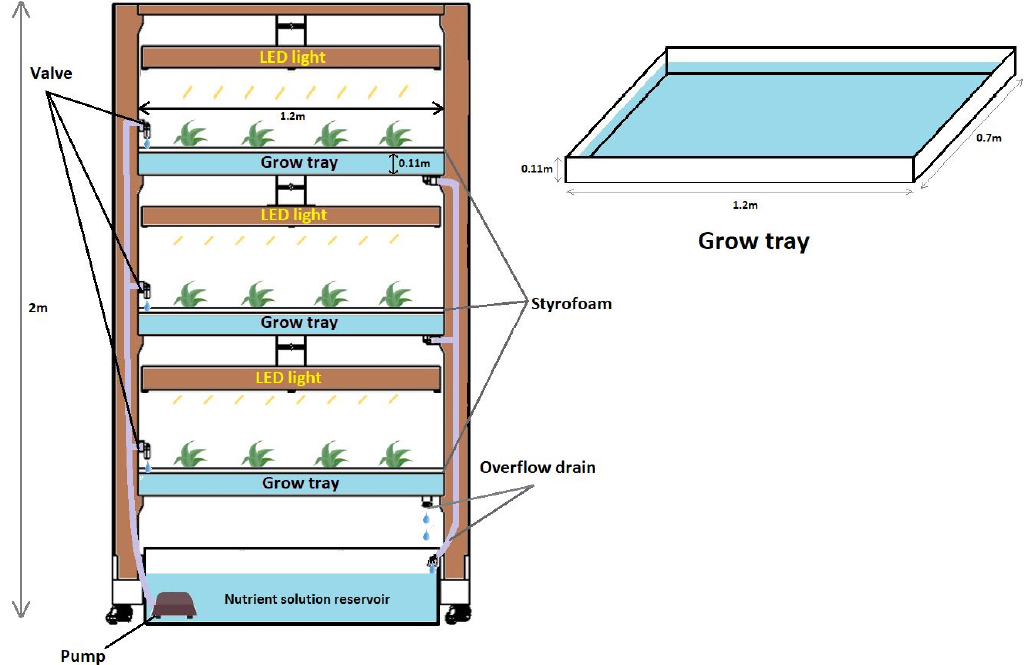
Figure 1. A deep flow technique (DFT) system in a plant factory. The plants were transplanted on a Styrofoam board, which was placed on the surface of the nutrient Styrofoam board, which was placed on the surface of the nutrient solution.